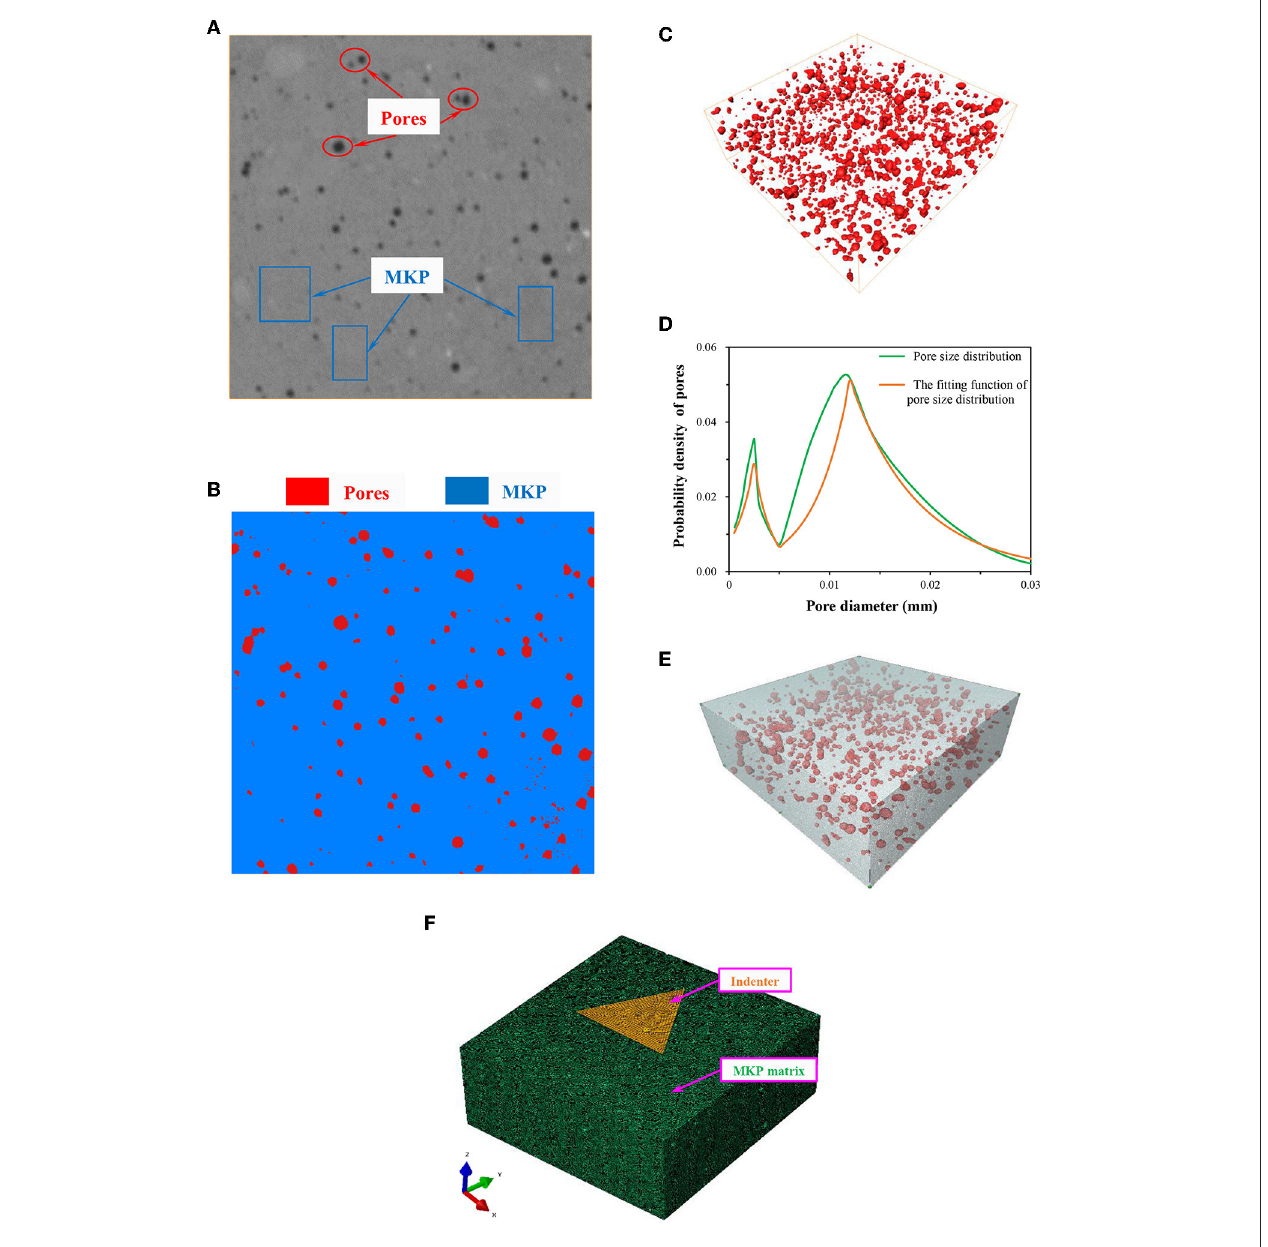
FIGURE 2 | The modeling process of P 14 indentation point based on X-CT (A) the 160th slice of the P 14 indentation point; (B) the result of the threshold segmentation of the 160th slice; (C) the distribution characteristics of the pores; (D) the pore size distribution curve; (E) the tetrahedral meshes based on the X-CT model; (F) The X-CT nanoindentation model of the